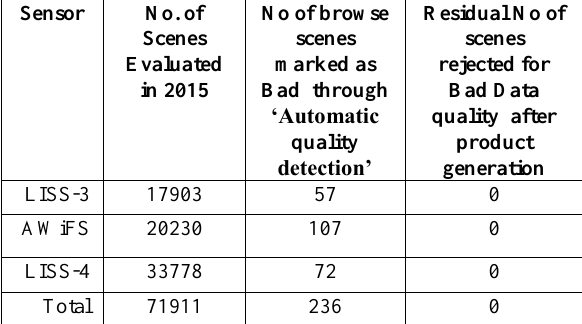
Table 2. Number of full resolution scenes evaluated by the automated process